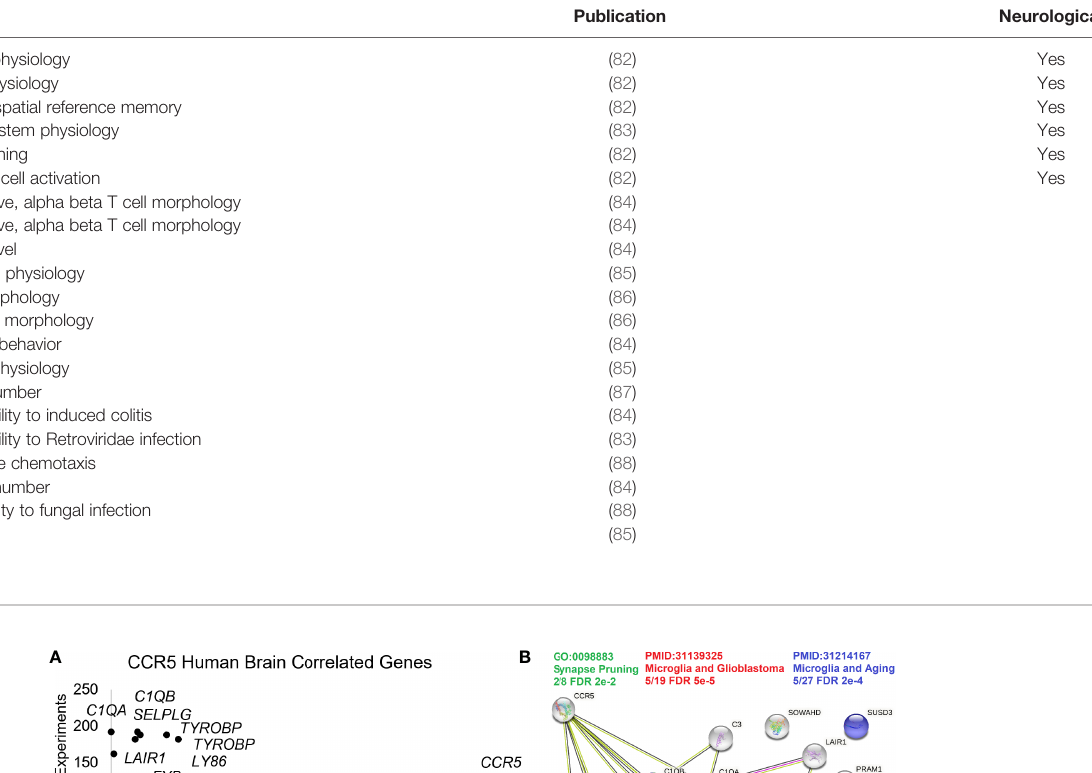
TABLE 4 | Mouse knock-out phenotypes.